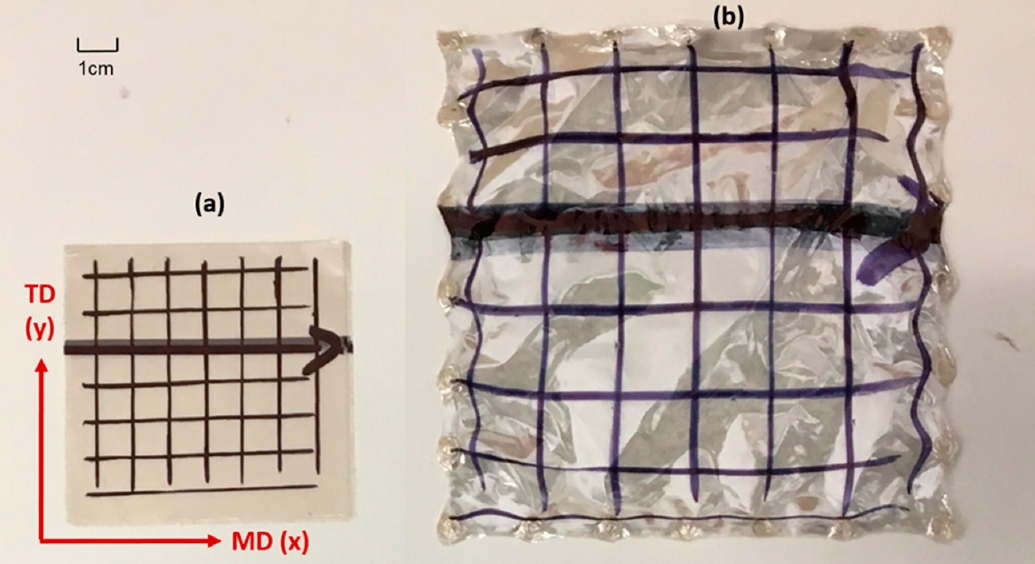
Figure 2. Equal Biaxial deformation of PEEK specimens ( a ) unstretched and ( b ) biaxially stretched to a ratio of 2 by 2 [13].